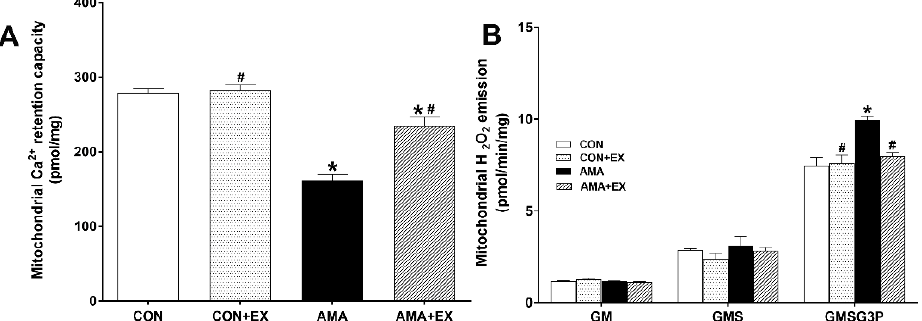
Figure 3. Effects of maternal exercise on mitochondrial Ca 2+ retention ( A ) and H 2 O 2 emission ( B ) in the hippocampus of offspring from mothers with advanced maternal age (AMA). CON: offspring from the control group; CON + EX: offspring from the control and exercised group; AMA: offspring from the advanced maternal age group; AMA + EX: offspring from the advanced maternal age and exercised group; GM: glutamate + malate; GMS: GM + succinate; GMSG3P: GMS + glycerol-3- phosphate. Data are expressed as means ± standard error of the mean (SEM). * p < 0.05 compared to the CON group. # p < 0.05 compared to the AMA